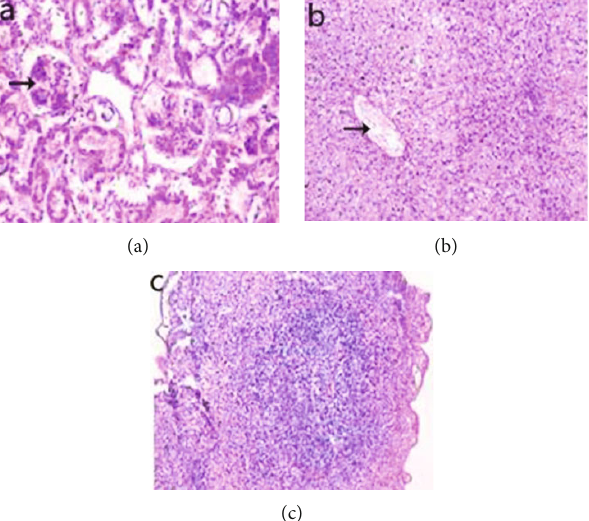
Figure 12: Histological section of negative control (healthy control) staining with H&E: (a) control kidney showing normal cortical structure ( × 200); (b) control liver showing normal hepatic lobular architecture ( × 100); (c) control spleen showing normal architecture ( × 100).